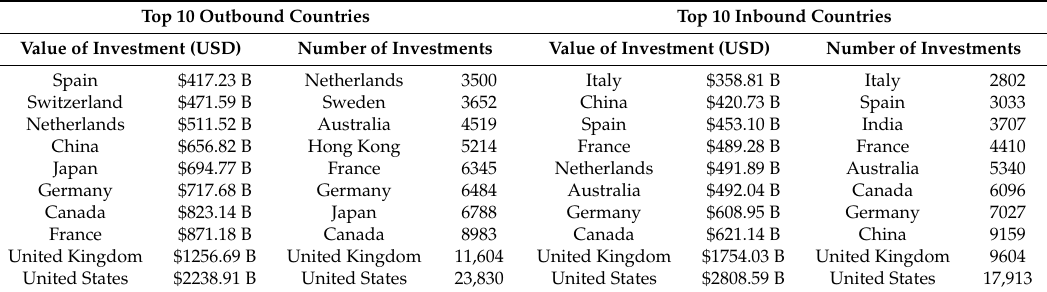
Figure 7. Outbound and Inbound M&A (2003–2016). Europe and North America show both outbound ( left ) inbound investments ( right ). Table 1. Summary of top ten nations inbound and outbound M&As (2003–2016). Top 10 Outbound Countries Top 10 Inbound